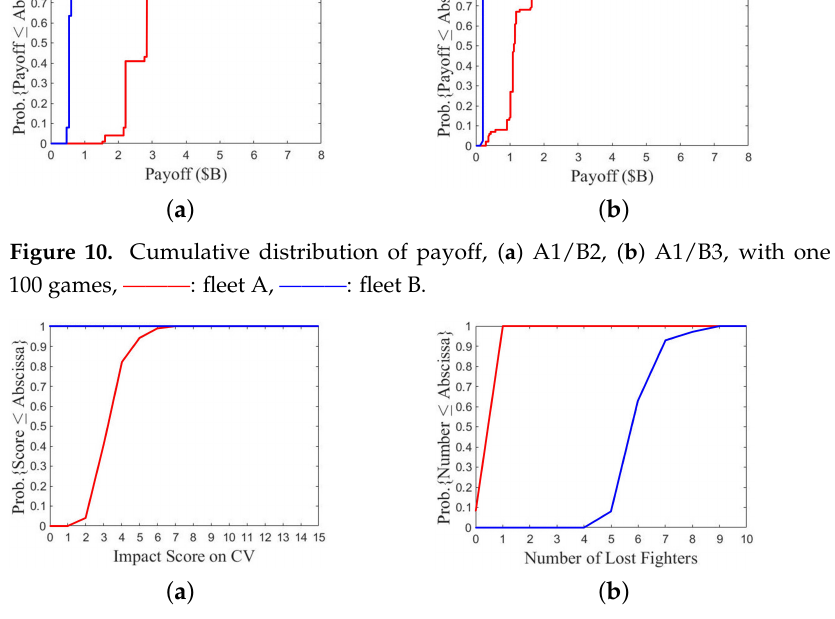
Figure 11. (A1/B2) Cumulative distribution of ( a ) impact score on CV and ( b ) lost fighters, over 100 games with one P 2 SO run, ———: fleet A, ———: fleet